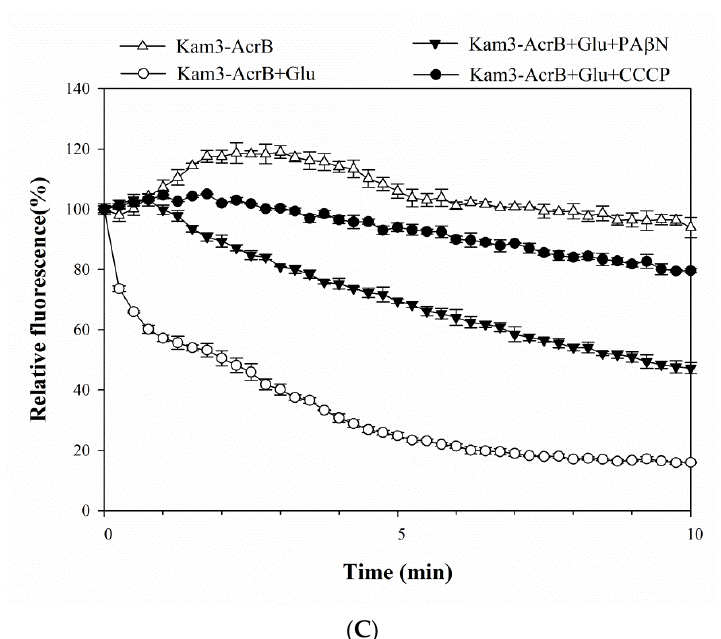
Figure 3. Efflux of dye ( A ) H33342, ( B ) EtBr, ( C ) Nile red in Kam3-AcrB in the presence of glucose and efflux pump inhibitor PA β N and CCCP. The fluorescence was recorded at excitation/emission wavelengths of 360/460, 520/600, 550/636 nm, respectively, over a 10 min incubation period. Glu, glucose. Values are expressed as mean ± standard deviation (SD) ( n = 3).